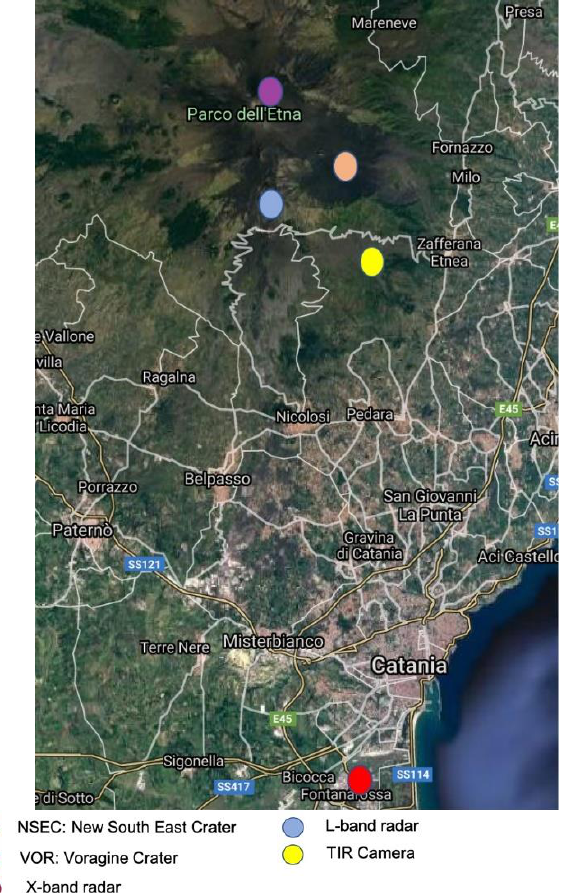
Figure 1. Map of location of three remote sensing sensors used in this study.